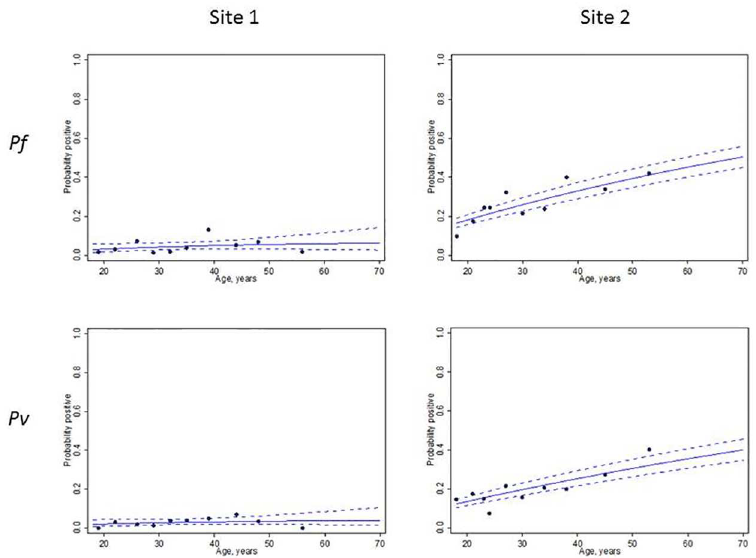
Fig 2. P . falciparum (upper boxes) and P . vivax (lower boxes) seroprevalence curves for each site. Circles representactual data points (placed at percentiles, solid blue line is the maximum likelihoodfitted model and dotted lines represent 95% CI for the